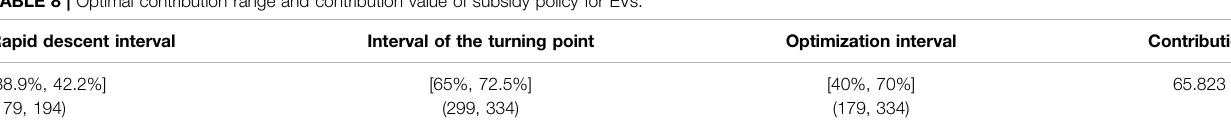
TABLE 8 | Optimal contribution range and contribution value of subsidy policy for EVs. Rapid descent